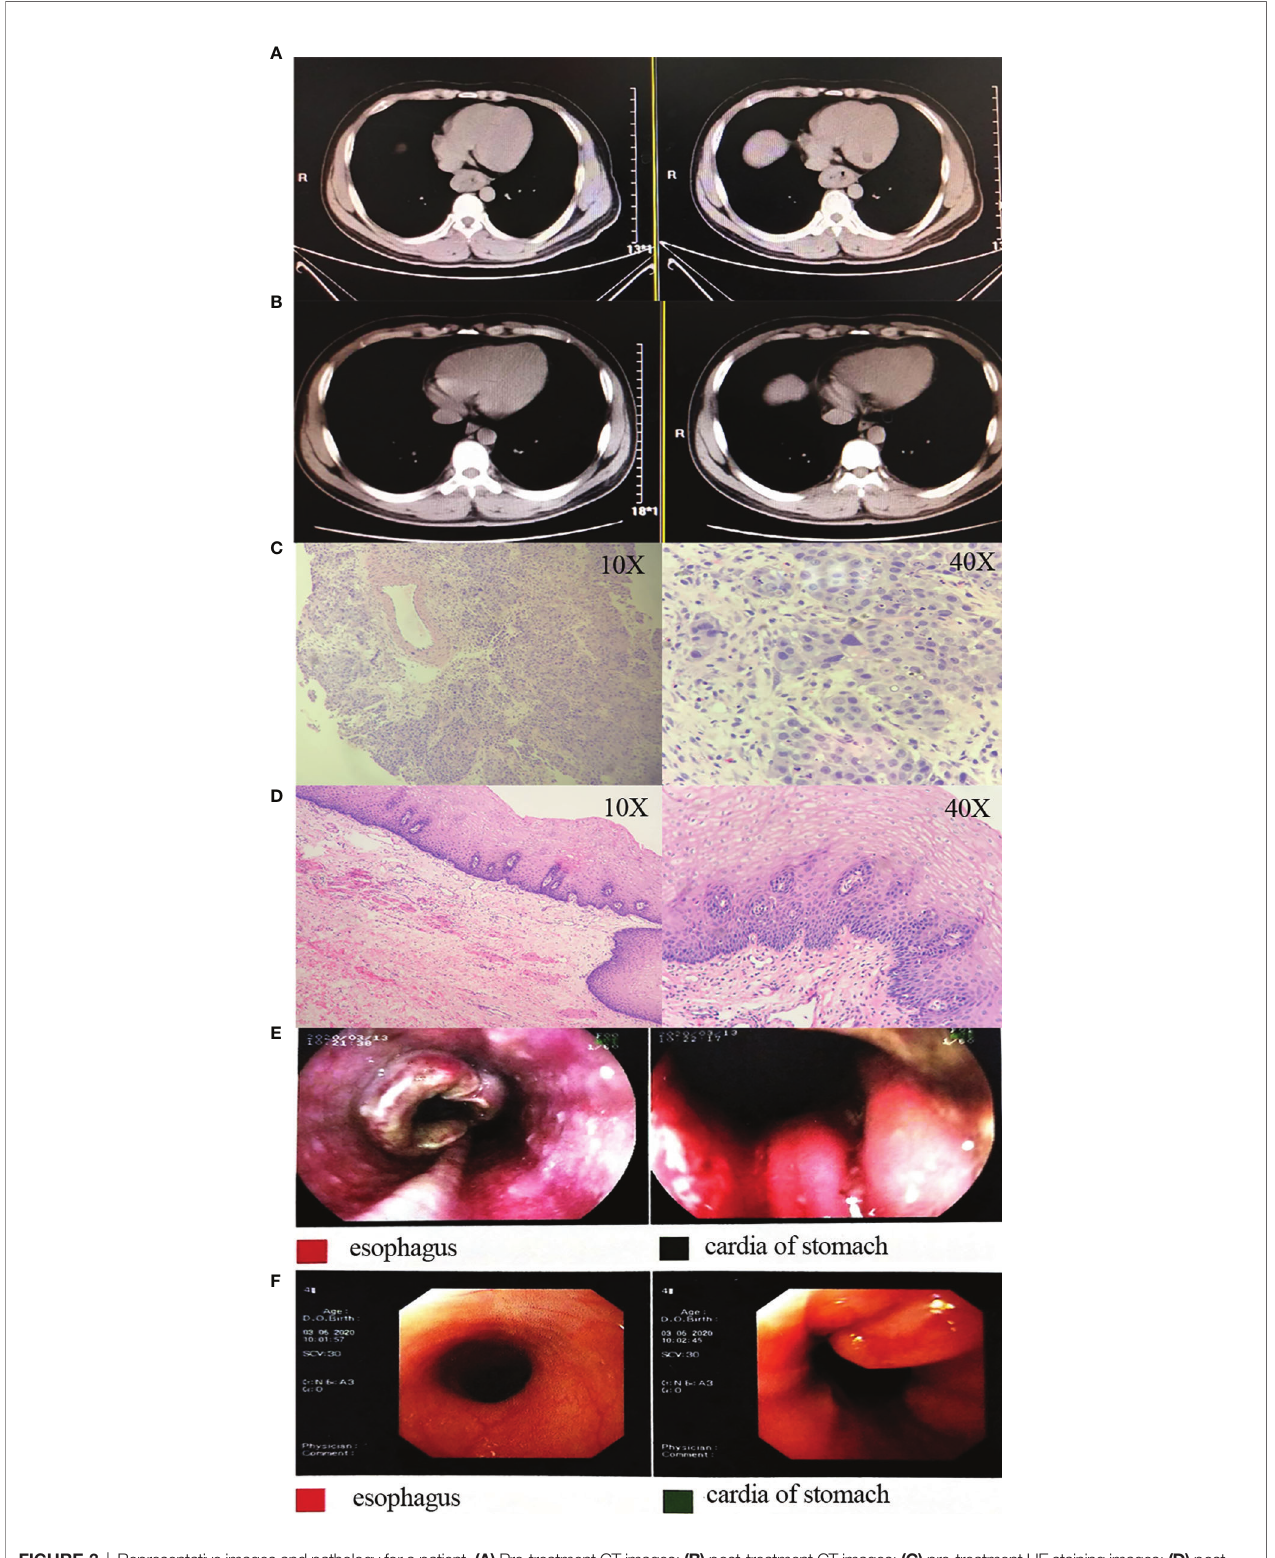
FIGURE 3 | Representativeimages andpathologyfor apatient. (A) Pre-treatmentCTimages; (B) post-treatment CTimages; (C) pre-treatmentHEstainingimages; (D) post operativeHEstainingimages; (E) pre-treatmentgastroscopyimages; (F) post-treatmentgastroscopyimages. CT, computedtomography;